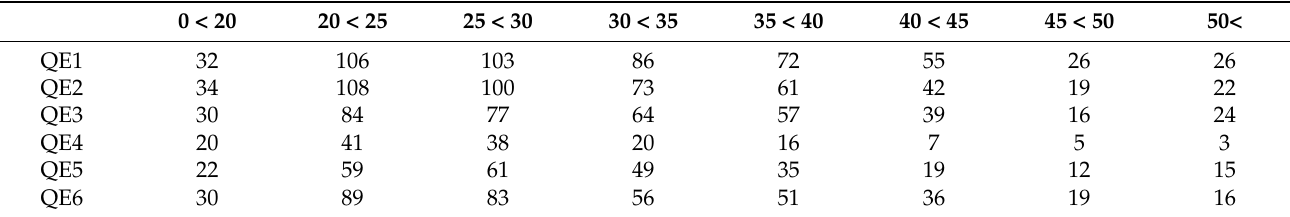
Table 11. Game elements distributed by age.